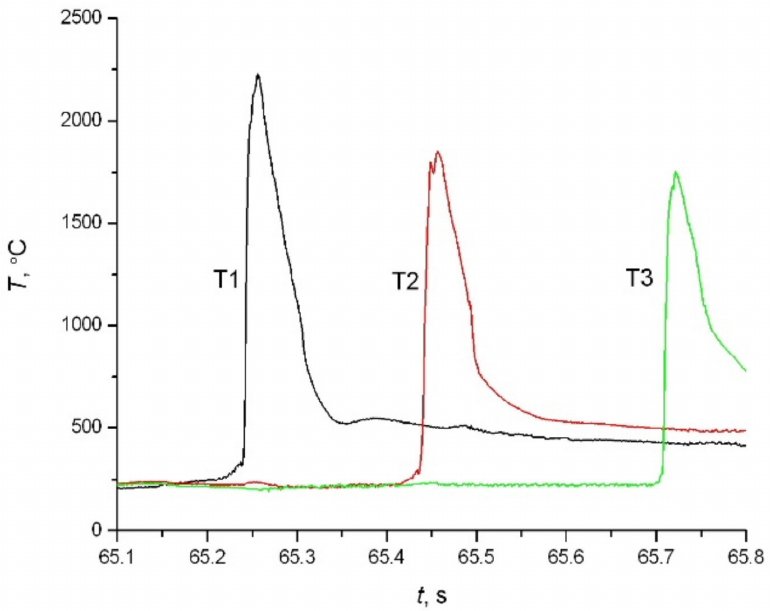
Figure 11. Readings of thermocouples T1–T3 during combustion of Set 3 (cf. Figure 1 and Table 2).